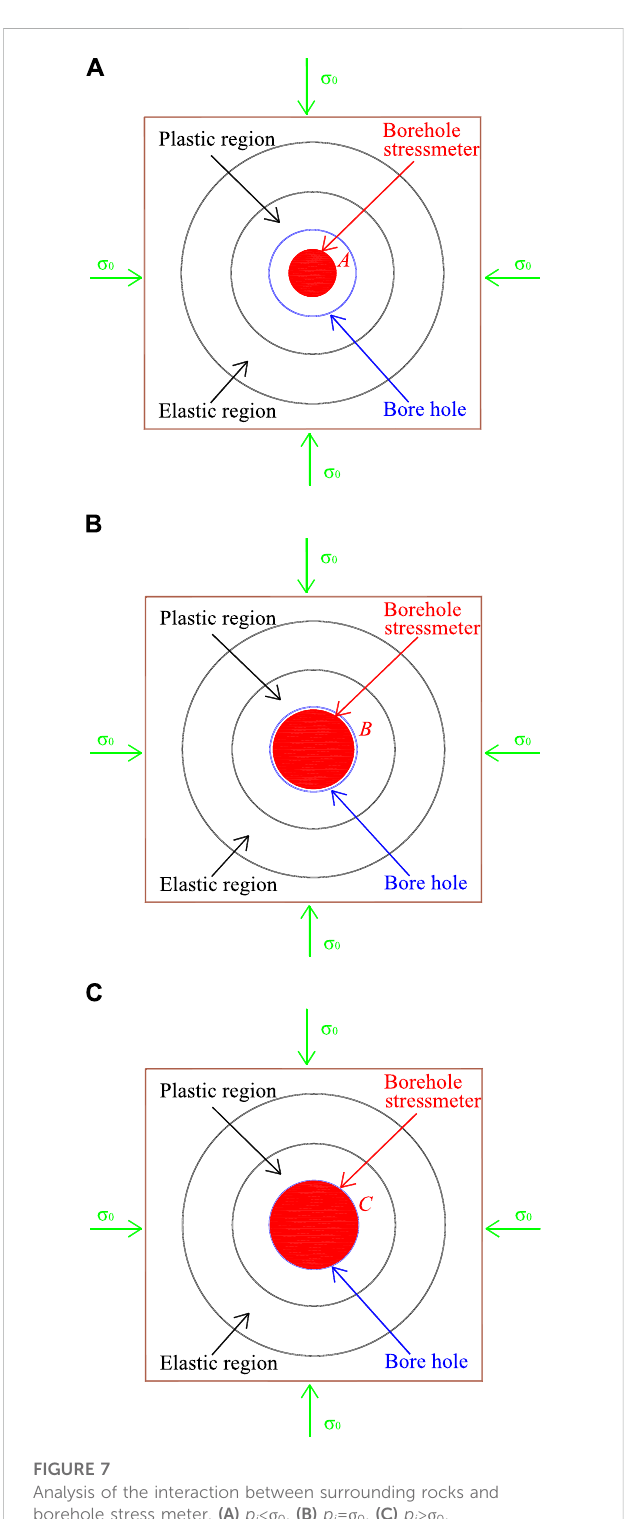
FIGURE 7 Analysis of the interaction between surrounding rocks and borehole stress meter. (A) p i < σ 0 . (B) p i = σ 0 . (C) p i > σ 0